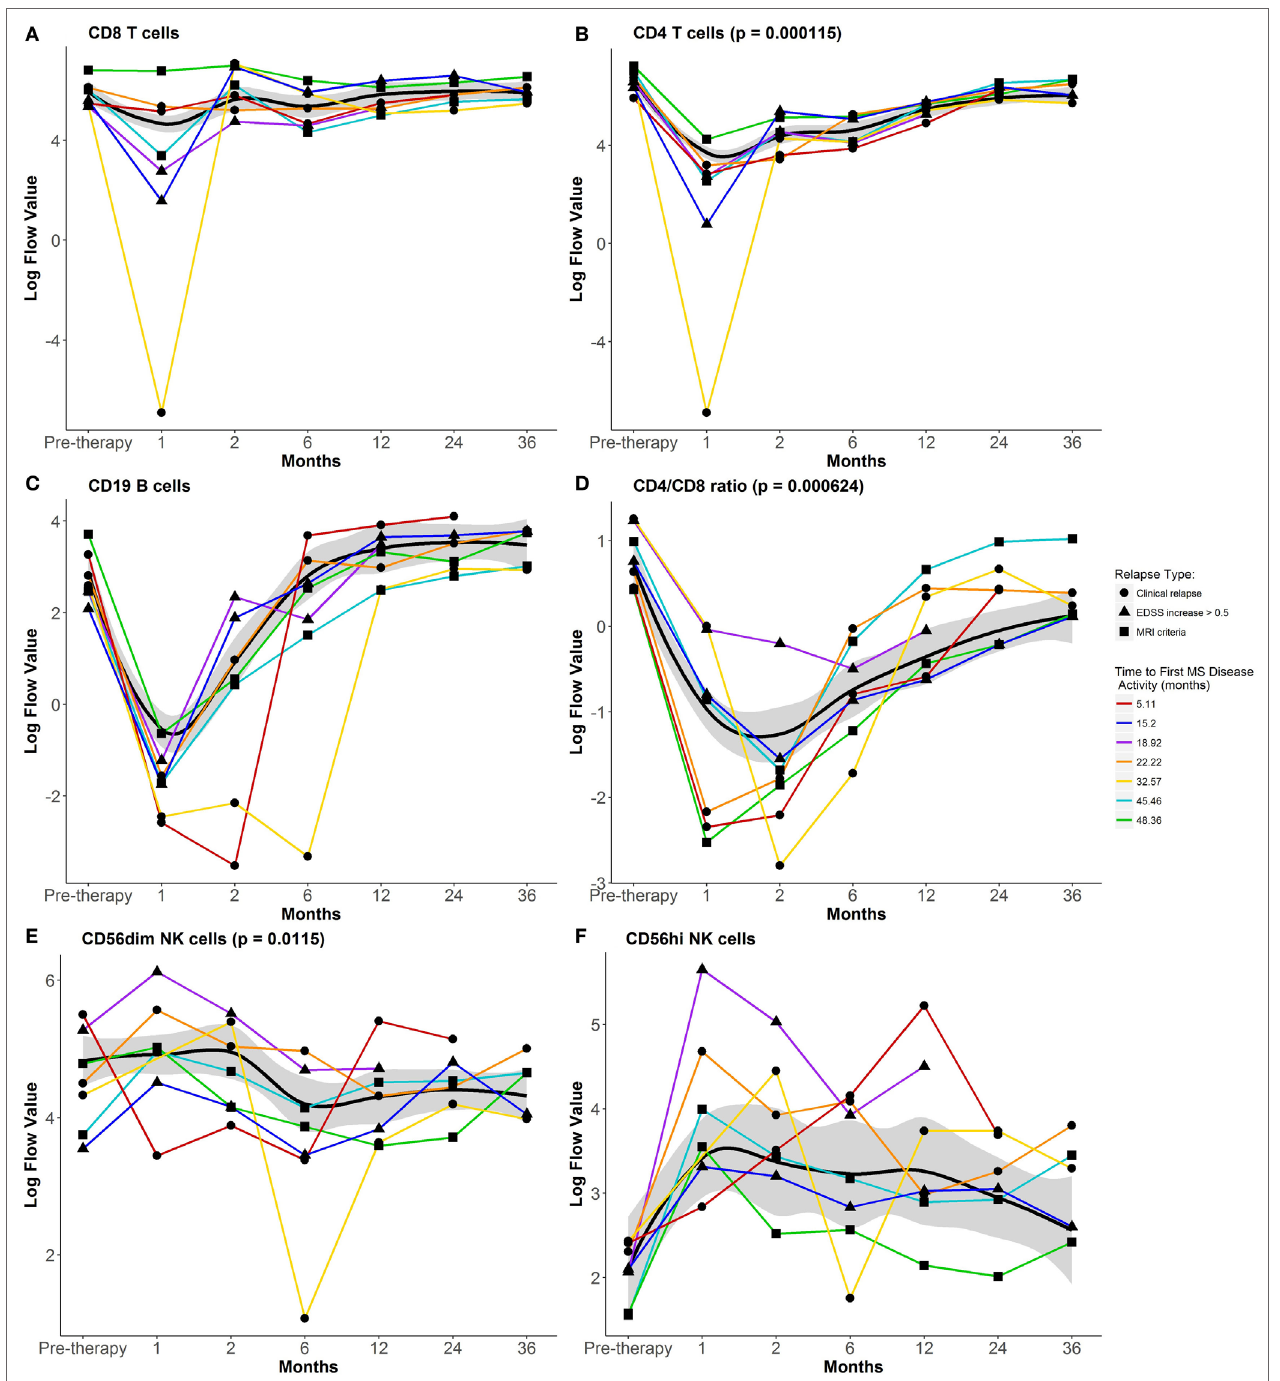
FigUre 1 | Impact of autologous hematopoietic stem cell transplantation (AHSCT) on numbers of circulating lymphocyte populations through 36 months follow-up. Absolute cell numbers per microliter of whole blood were analyzed for (A) CD8 T cells, (B) CD4 T cells, (c) CD19 B cells, (e) CD56 dim NK cells, and (F) CD56 hi NK cells. (D) CD4/CD8 ratios were calculated from absolute cell numbers (A,B) . Flow data were plotted after log transformation for normalization of these variables. Data shown are mean values for the group that maintained remission through 60 months post-AHSCT. The black line represents the Loess Regression fitted curve with a span = 0.7, and its 95% confidence band colored in gray. Paired t -test was used to examine persistent changes at 36 months from pretherapy numbers within the group that maintained remission through 60 months post-AHSCT (n = 15). CD4 T cells, CD4/CD8 T cell ratio, and CD56 dim NK cells were reduced from pretherapy numbers at 36 months post-AHSCT. Individual lines for the seven participants who experienced disease reactivation prior to 60 months post-AHSCT are plotted using different symbols to indicate the type of disease activity and different colored lines to indicate the time to first multiple sclerosis (MS) disease activity. For additional details including flow cytometry data without log-transformation, see https://www.itntrialshare.org/HALTMS_fimmu_fig1.url.